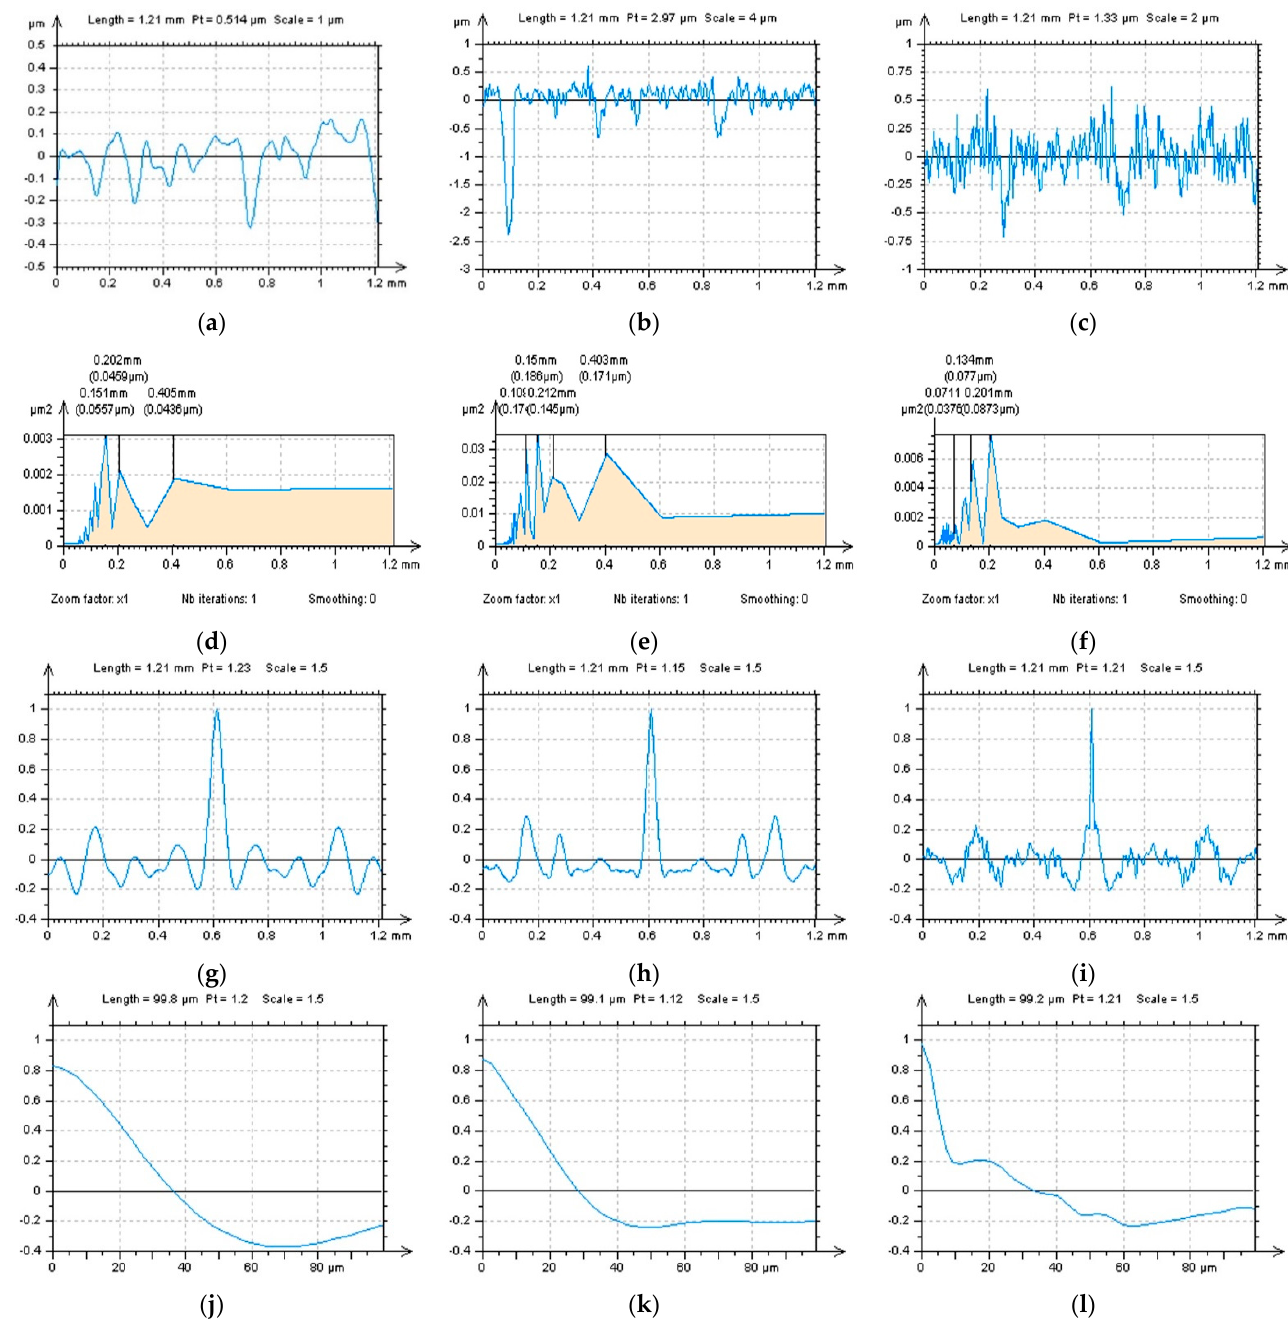
Figure 3. Extracted from a plateau ‐ honed cylinder liner surface with additionally burnished dimples profiles ( a – c ): raw measured data (left column), containing high–frequency noise with a dimple (middle) and free ‐ of ‐ feature (right column), their PSDs ( d – f ), ACFs ( g – i ) and centre–part of ACFs ( j – l ) respectively.